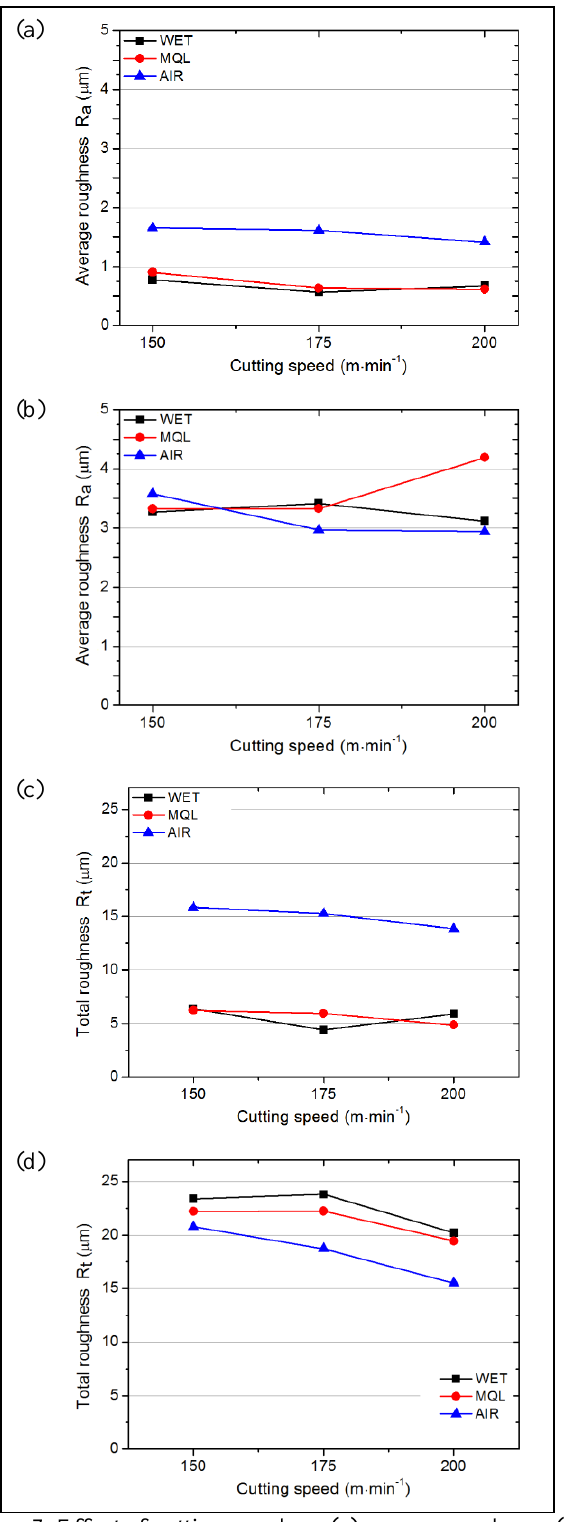
Figure 7: Effect of cutting speed on: (a) average roughness ( R a ) for SG; (b) average roughness ( R a ) for PG; (c) total roughness ( R t ) for SG; (d) total roughness ( R t ) for